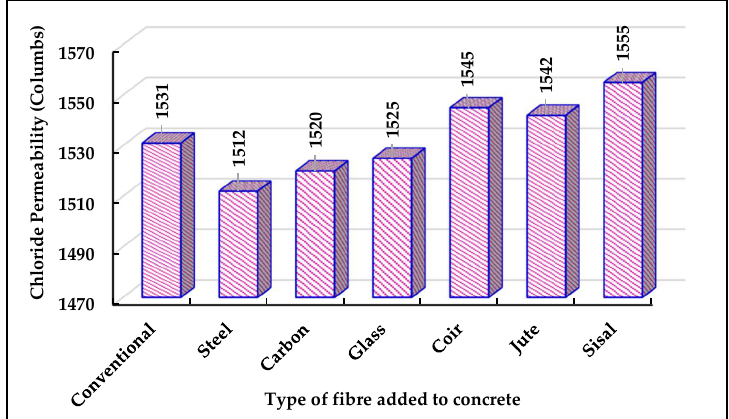
Figure 12. Graphical illustration of Chloride Permeability of FRC.